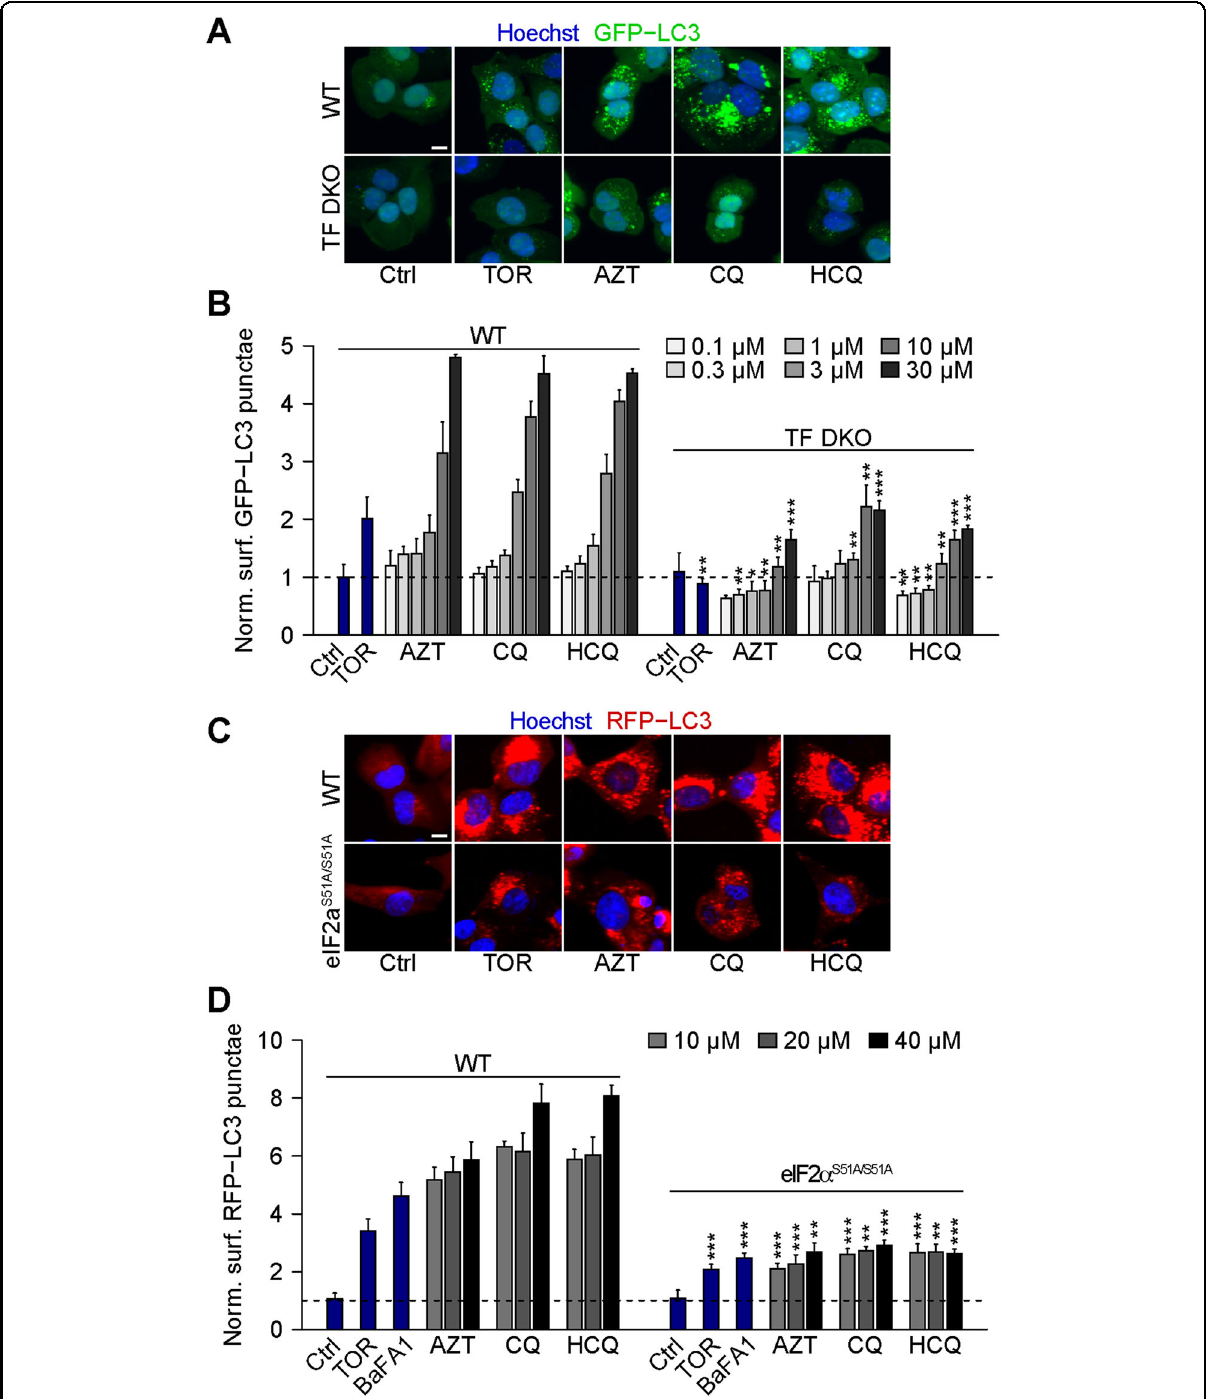
Fig. 3 Chloroquine, hydroxychloroquine, and azithromycin-induced autophagy depends on TFEB/TFE3 and eIF2 α . A , B Human osteosarcoma U2OS wild type (WT) or TFEB/TFE3 double KO (TF DKO) cells both stably expressing GFP-LC3 were treated with the indicated compounds (torin 1 (TOR; 300nM), chloroquine (CQ), hydroxychloroquine (HCQ), and azithromycin (AZT; all at 0.1, 0.3, 1, 3, 10, 30 μ M)) for 6h. After fi xation, GFP-LC3 dots were analyzed as a proxy for autophagy. Representative images are depicted in A (AZT, CQ, and HCQ, 30µM) and normalized data are shown as bar chart in B . Data are means± SD of four replicates (** P <0.01, *** P < 0.001 vs. WT; Student ’ s t -test). C , D U2OS WT or PeIF2 α S51A knockin cells both expressing RFP-LC3 were treated as indicated with TOR (300nM), ba fi lomycin A1 (BafA1, 100nM), CQ, HCQ, and AZT (all at 10, 20, 40 μ M) for 6 h. After fi xation, RFP-LC3 dots were analyzed by fl uorescent microscopy. Representative images are shown in C (AZT, CQ, and HCQ, 40µM) and normalized data are quantitated as a bar plot in D . Data are means±SD of four replicates (** P <0.01, *** P < 0.001 vs. WT; Student ’ s t -test). Scale bars equal 10 μ m.